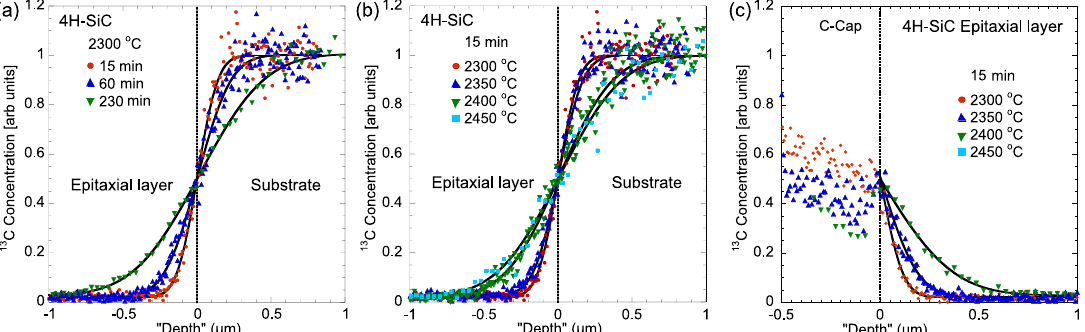
Figure 2. 13 C profiles as deduced by SIMS and fitted according to Equation (1), at ( a ) the interface between the isotope purified epi-layer and the substrate for 2300 ◦ C annealing for 15–230 min, ( b ) the interface between the isotope purified epi-layer and the substrate for 2300–2450 ◦ C annealing for 15 min, and ( c ) at the C-cap/epi-layer interface for 2300–2450 ◦ C annealing for 15 min. The corresponding 30 Si depth profiles are shown in Figure 3 at the 4H-SiC substrate/isotope purified epi-layer interface. The time dependence of Si motion at 2300 ◦ C is highlighted in Figure 3a, and temperature dependence in Figure 3b for 15 min isochronal annealing between 2300–2450 ◦